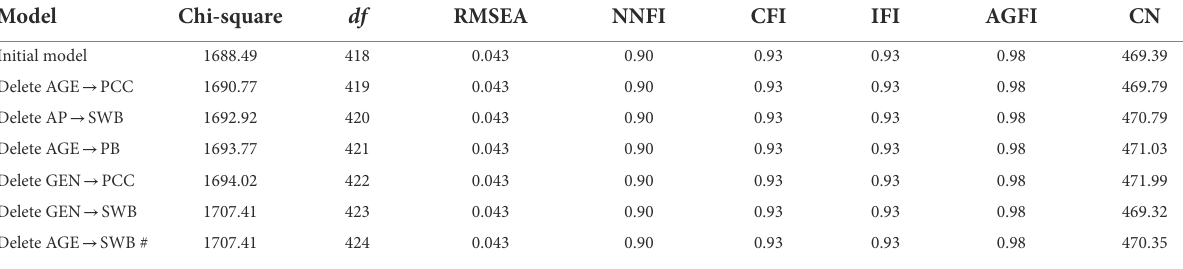
TABLE 3 Measures of goodness-of-fit for academic pressure and problem behavior model of the adolescents. Model